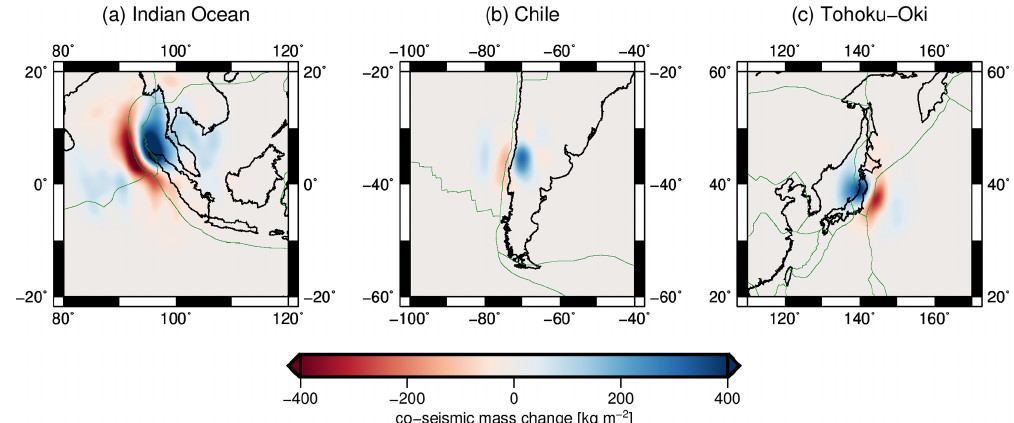
Figure 6. Estimated co-seismic mass change for all modeled earthquakes (230km Gaussian filter applied).